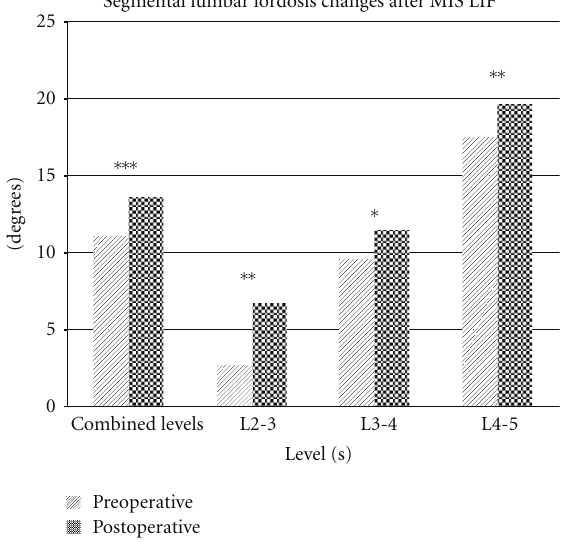
Figure 3: Segmental lumbar lordosis changes after MIS LIF. Statistically significant increases were observed at each measured level as well as in aggregate. ( ∗ = P < 0 . 05, ∗∗ = P < 0 . 01, ∗∗∗ = P < 0 .